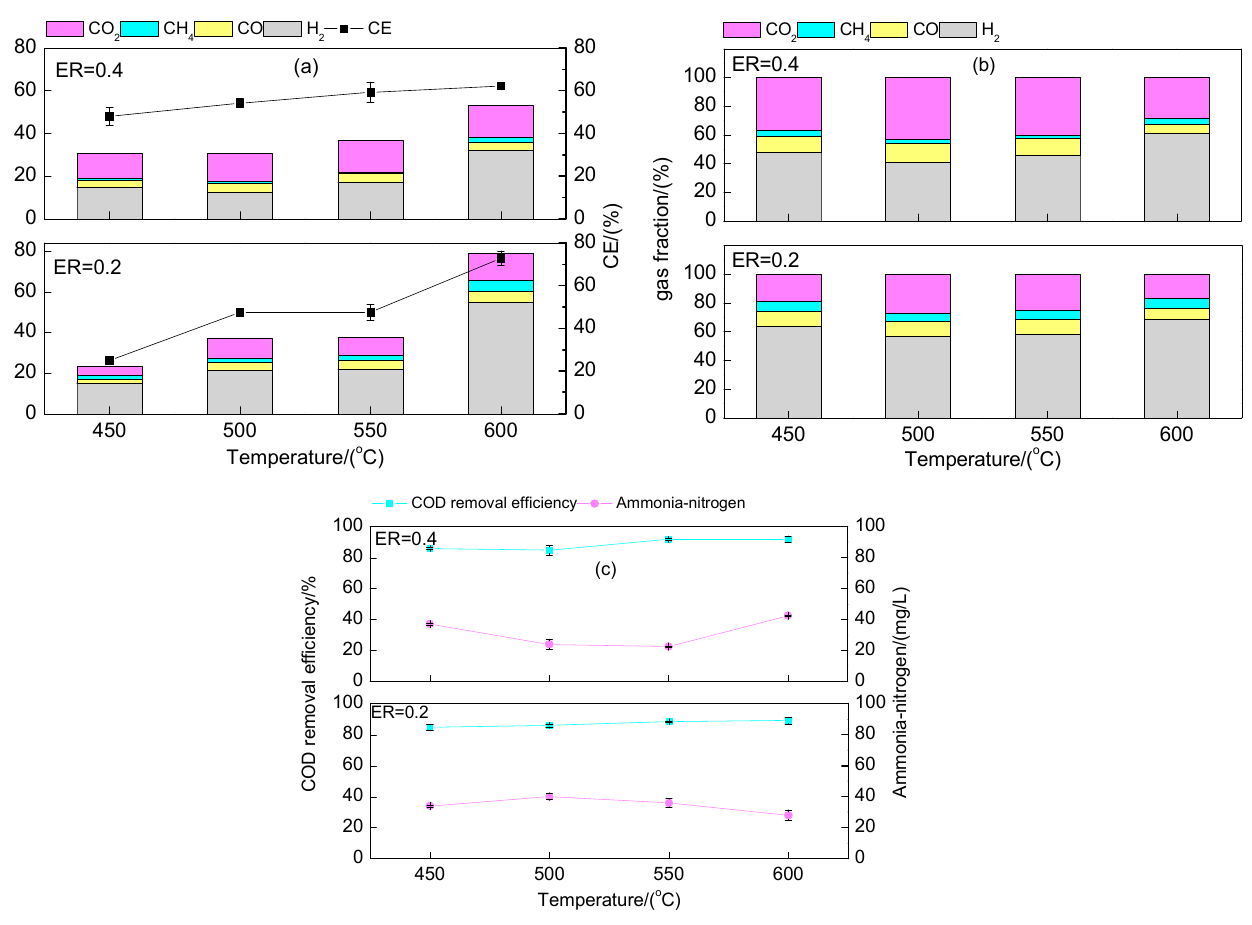
Figure 4. Effect of oxidant and ER on gasification characteristic: ( a ) gas yield and CE ( b ) gas fraction ( c ) COD removal efficiency and ammonia nitrogen (23 MPa, residence time 20 min) .